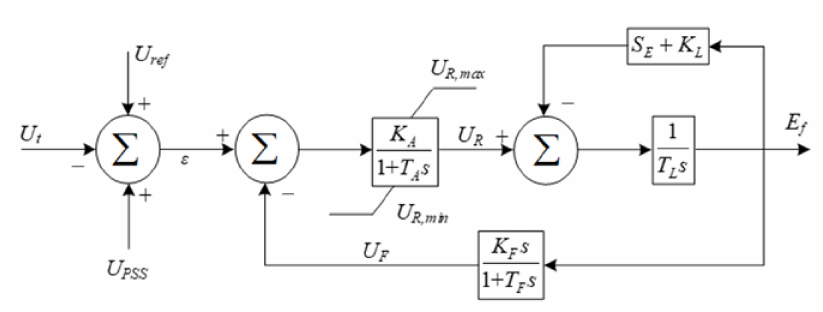
Figure 5. The block diagram of the excitation system.